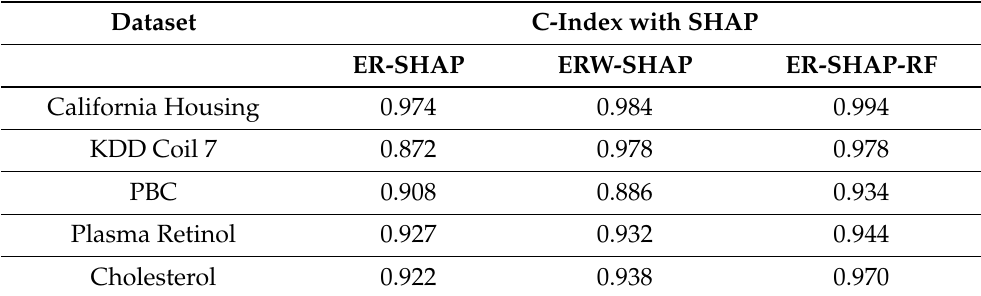
Table 2. Comparison of the proposed models with SHAP for several